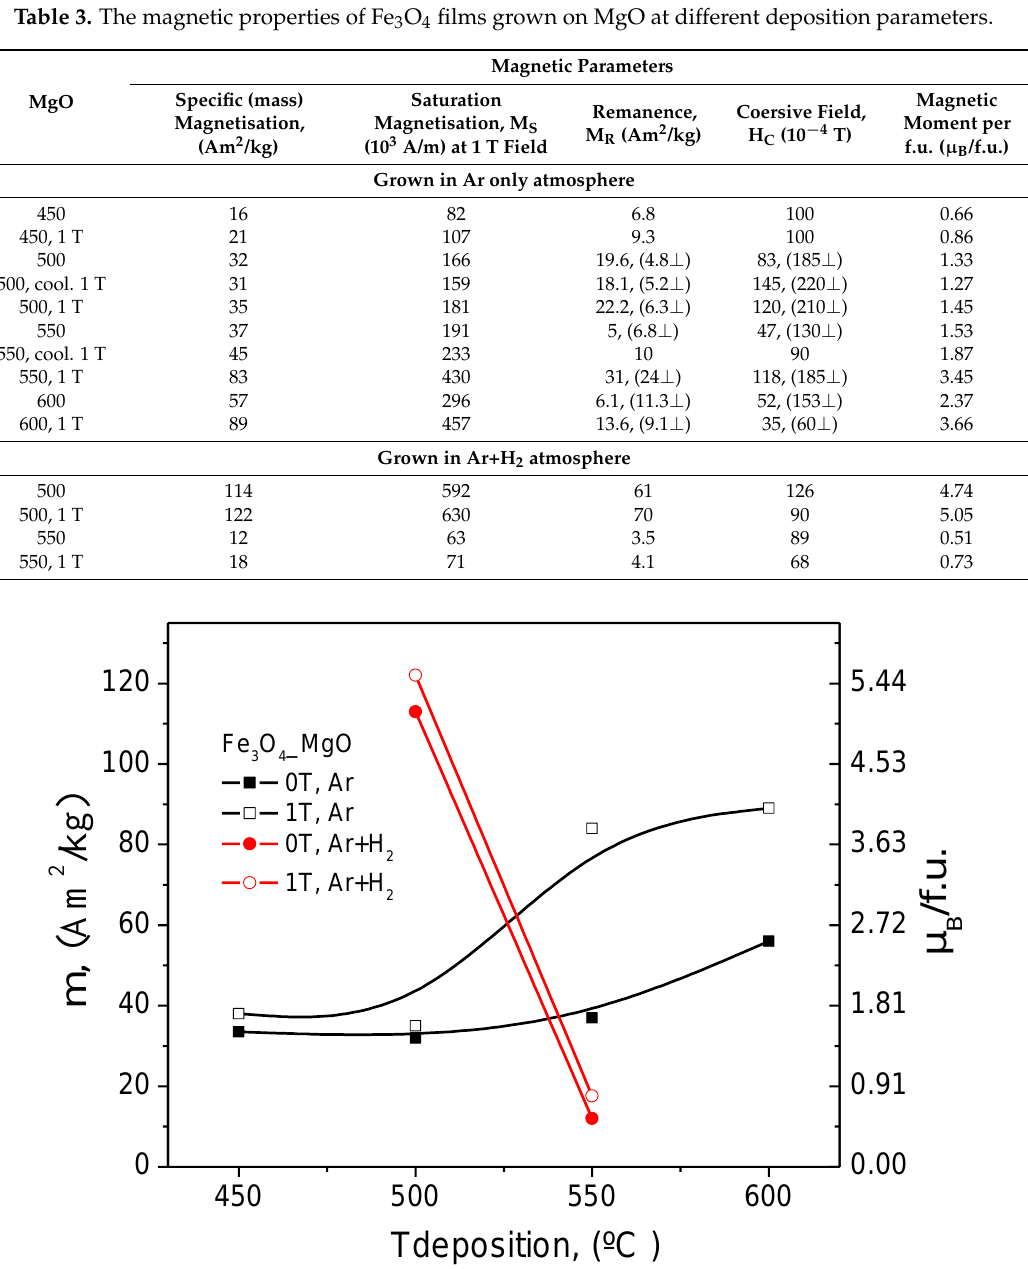
Figure 9. Graphic presentation of the M S and µ B /f.u. values versus deposition temperature for the films on MgO, grown in and without external magnetic field.